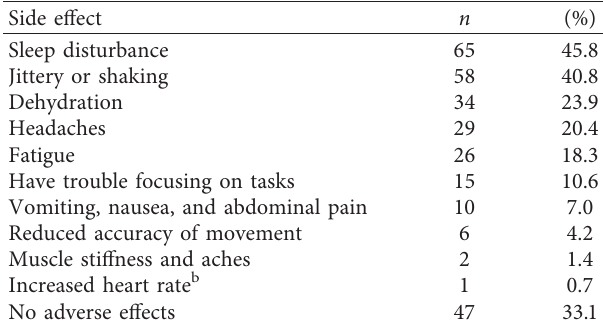
Table 4: Side effects of energy drinks amongst consumers ( n � 143) a .